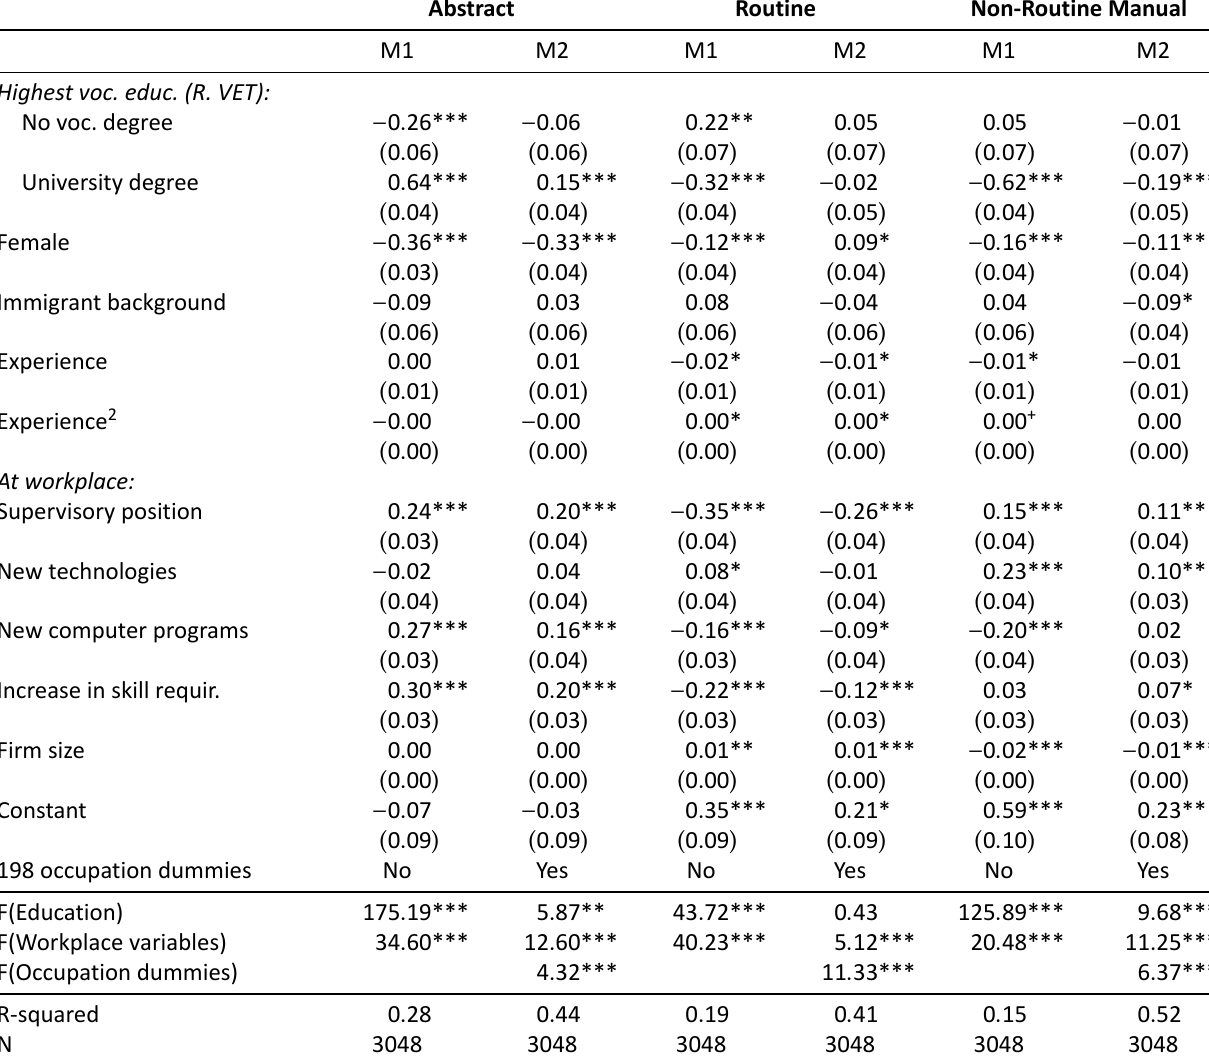
Table 3. OLS-Regressions of abstract, routine, and non-routine manual tasks without/with occupation fixed effects. Source: BIBB/BAuA Employment Survey 2012 and Supplemental Task Survey to the Employment Survey